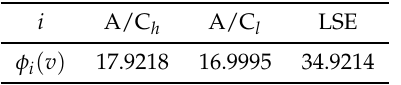
Table 9. Reward of players.